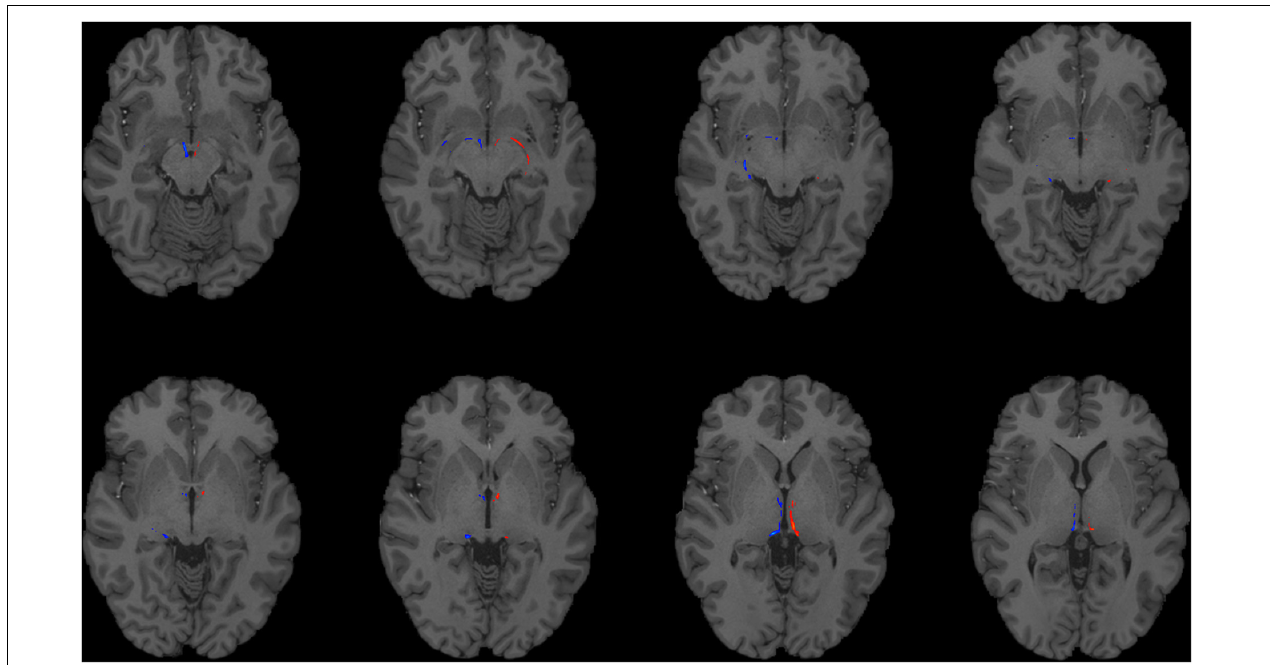
FIGURE 2 | Visualization of the LHb and 3D visualization of the SM and FR streamlines. (Left) Axial T1 image with the SM labeled in blue in a representative subject. The LHb is depicted on the image as the area of highest streamline density. (Right) 3D visualization of the SM and FR streamlines in a representative HCP subject. Legend: anterior (A), posterior (P), right (R), left (L), superior (S), inferior (I).